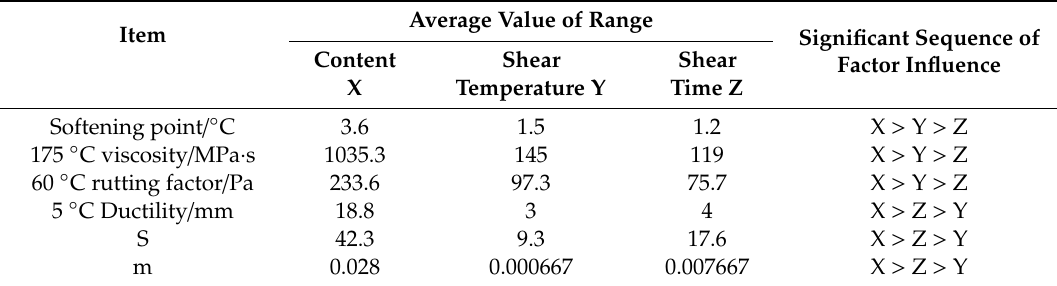
Table 6. Results of range